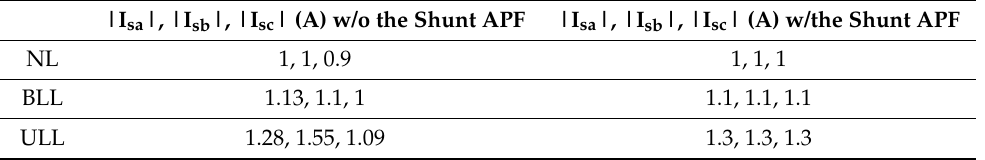
Figure 7. Source current (I s ), load current (I L ) and filter current (I f ) with the shunt APF when the source voltages are balanced. ( a ) V PCC , I s , I L and I f with NL ( b ) I s , I L and I f with BLL. ( c ) I s , I L and I f with ULL. Table 5. The magnitudes of I s without and with the shunt APF.